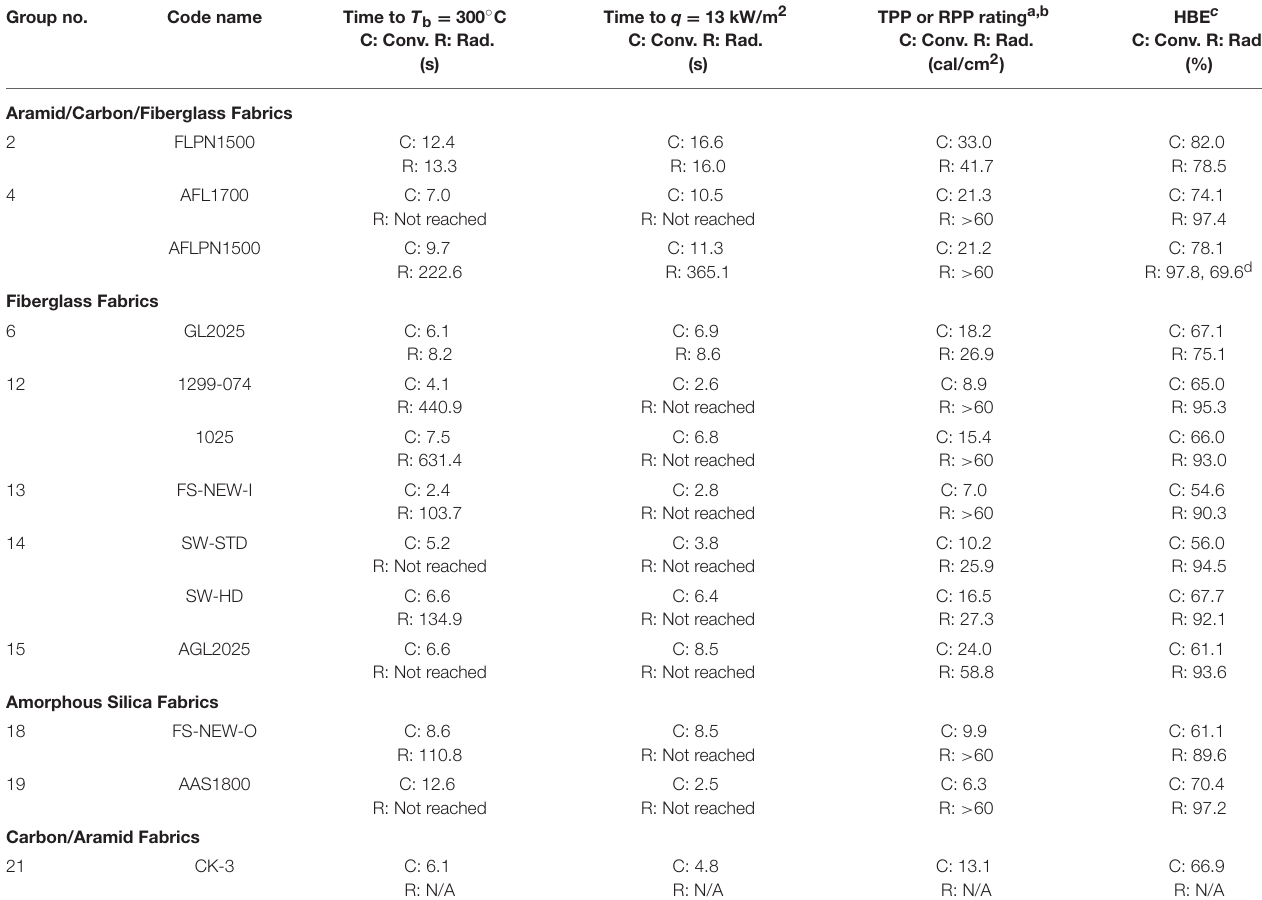
TABLE 2 | Measured thermal characteristics of single-layer fire blankets. Group no. Code